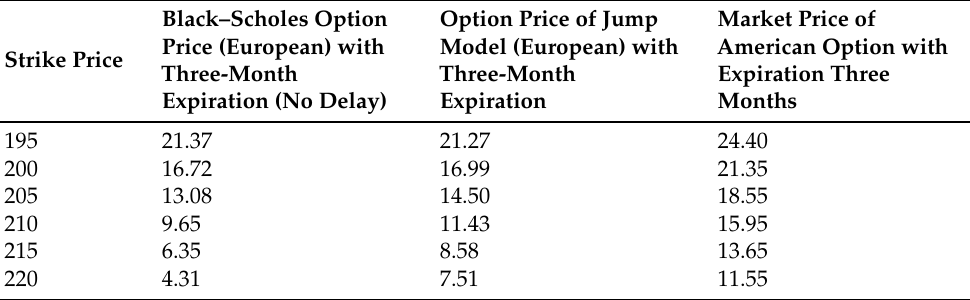
Table 2. Call option price comparison for T = 3 months for Microsoft stock.